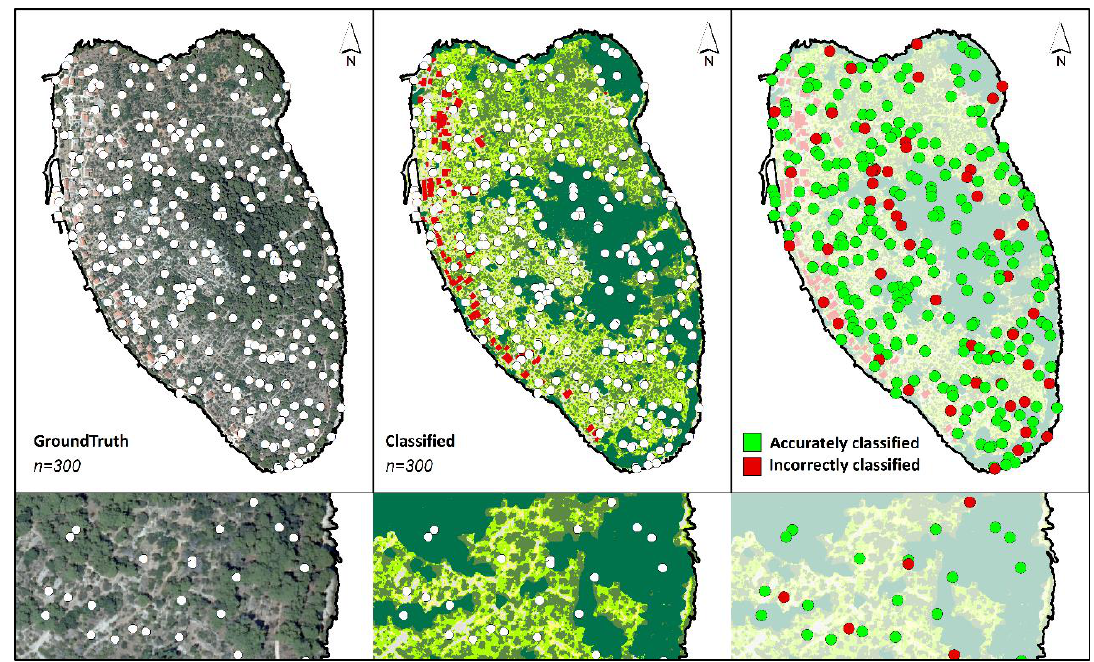
Figure 12. Example of accuracy assessment for the HAPs (2011).